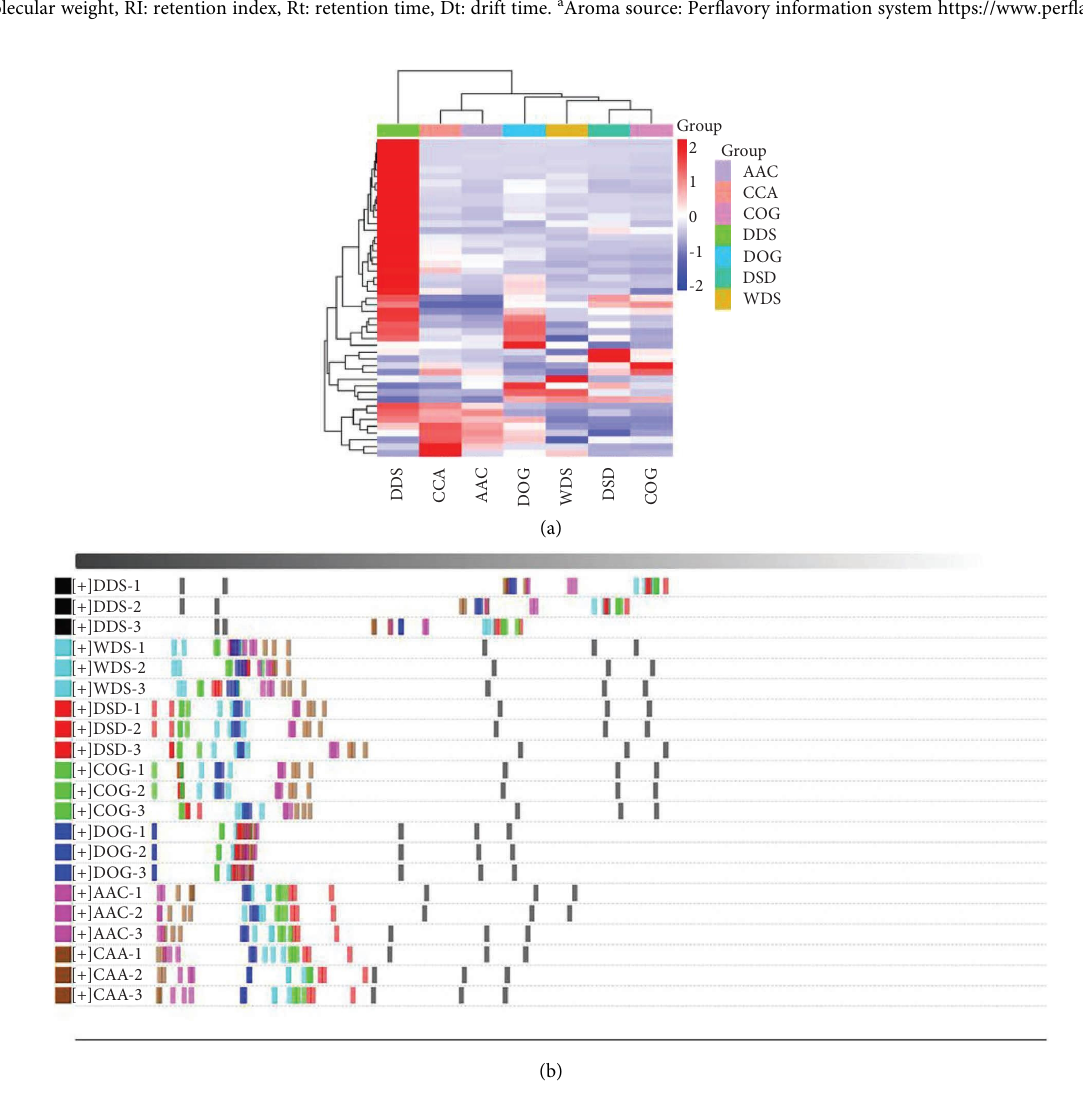
Figure 4: (a) Heatmap and (b) Euclidean distance diagram of volatile favor compounds in Ejiao at diferent processing